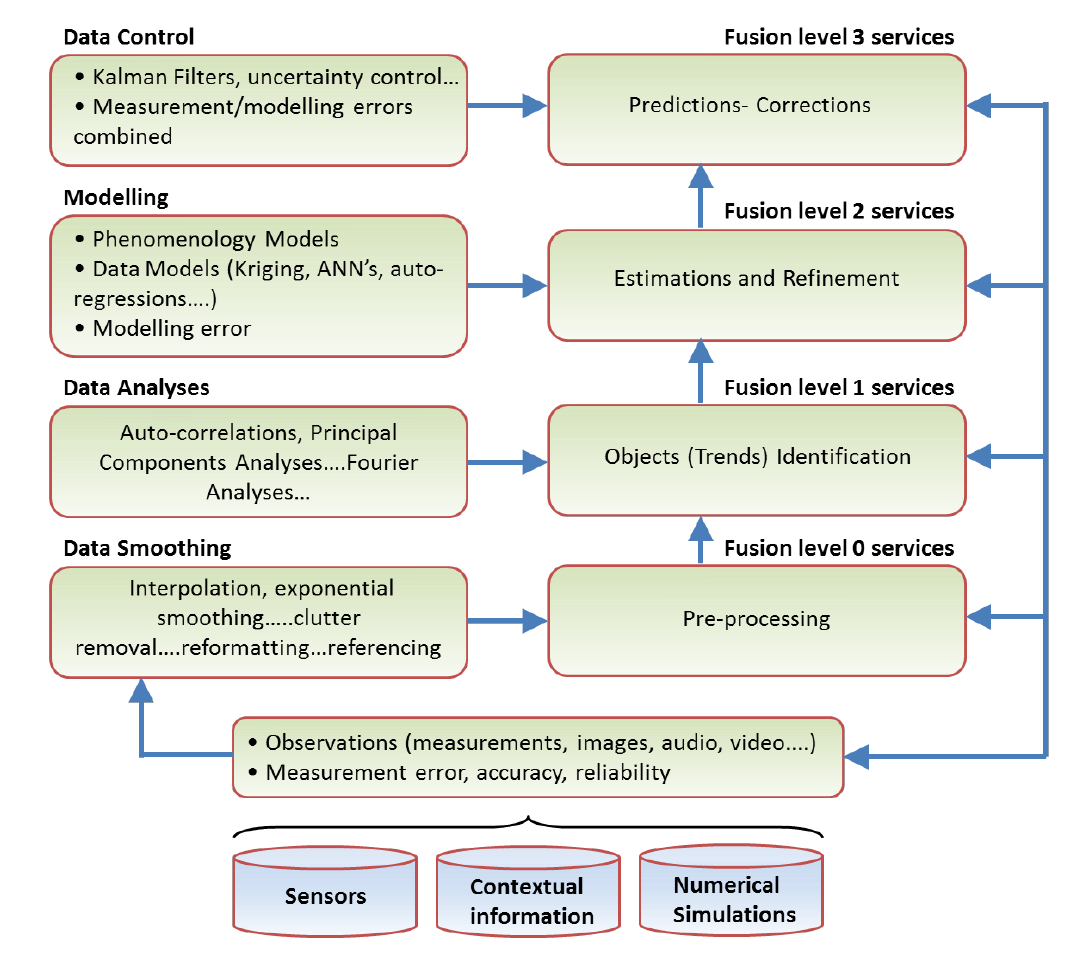
Figure 11. Multi-levelled Data fusion and Modelling